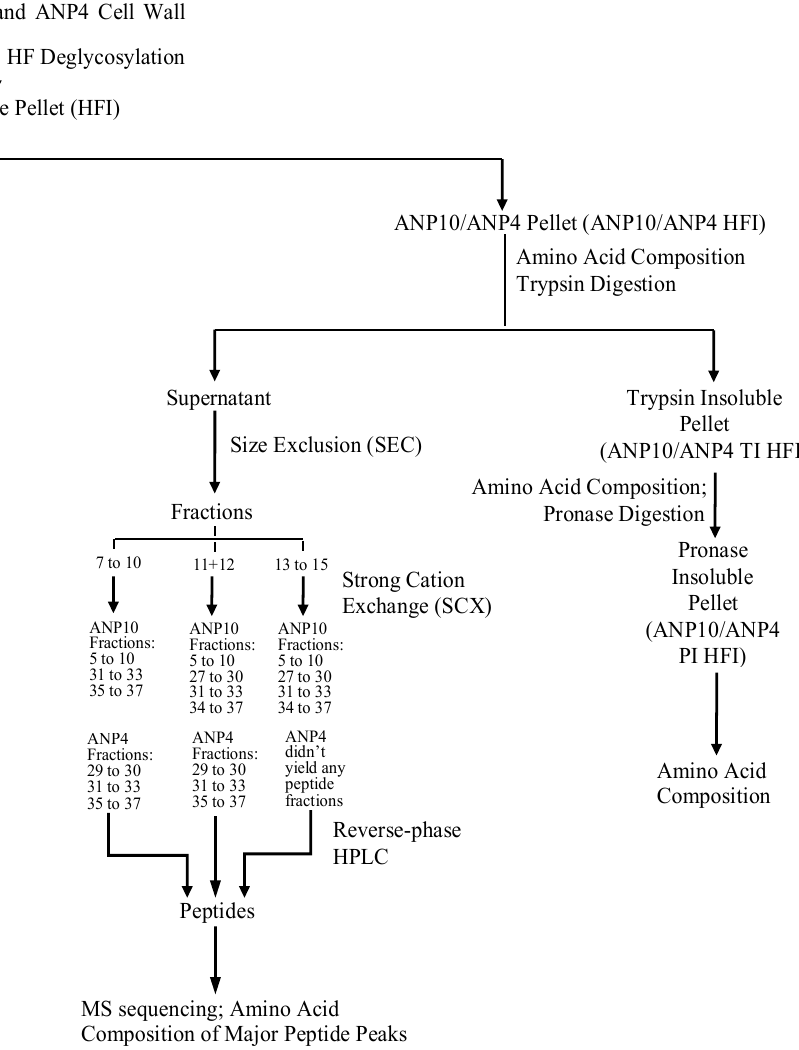
Figure 1. Flow chart outlining the isolation of WT, ANP10 and ANP4 root wall peptides. See Figures 2–4 for the peptide maps from the SEC, SCX and reverse-phase HPLC